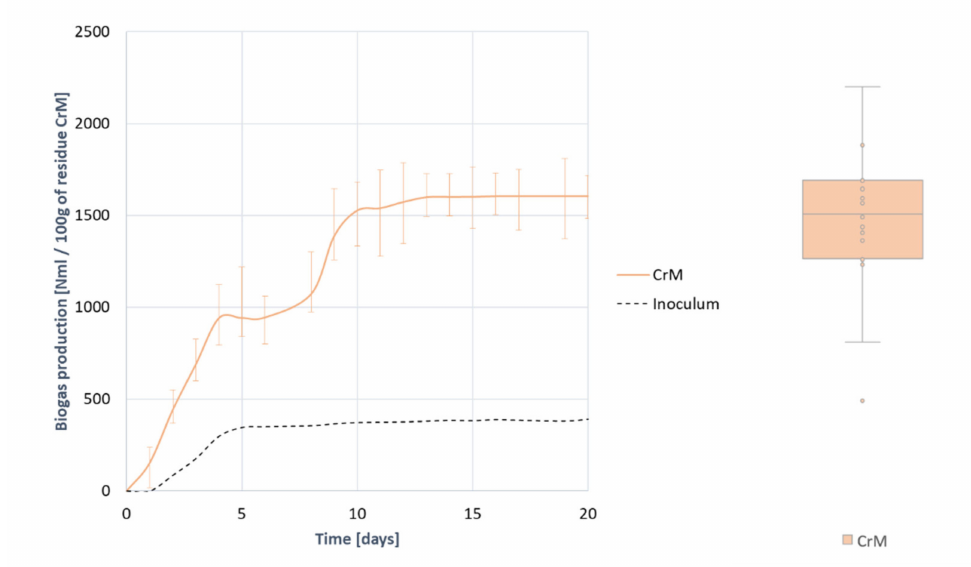
Figure 1. Gross biogas production mean curve from the anaerobic digestion of 100 g of residue (Crop Barley Residue) CrM, and box diagram of its